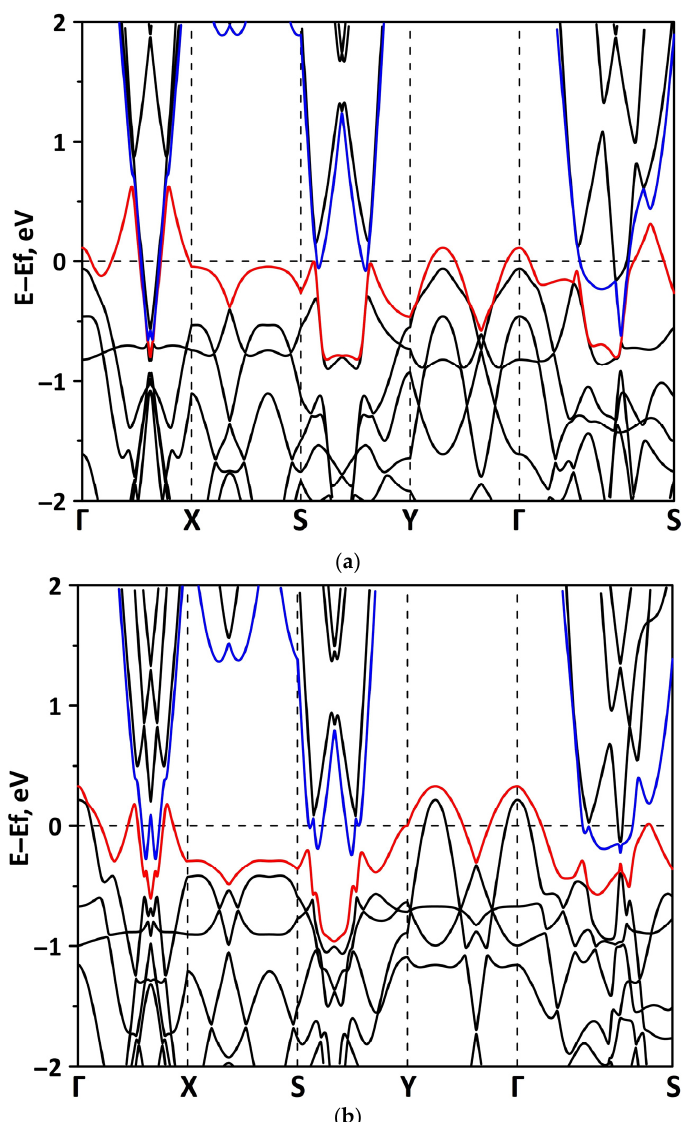
Figure 23. Fragments of the band diagrams near the Fermi level (shifted to 0 eV) of borophene/ZnO heterostructure under biaxial compression by 2% ( a ) and 6% ( b ). The VBM is highlighted in red and the CBM is highlighted in blue.